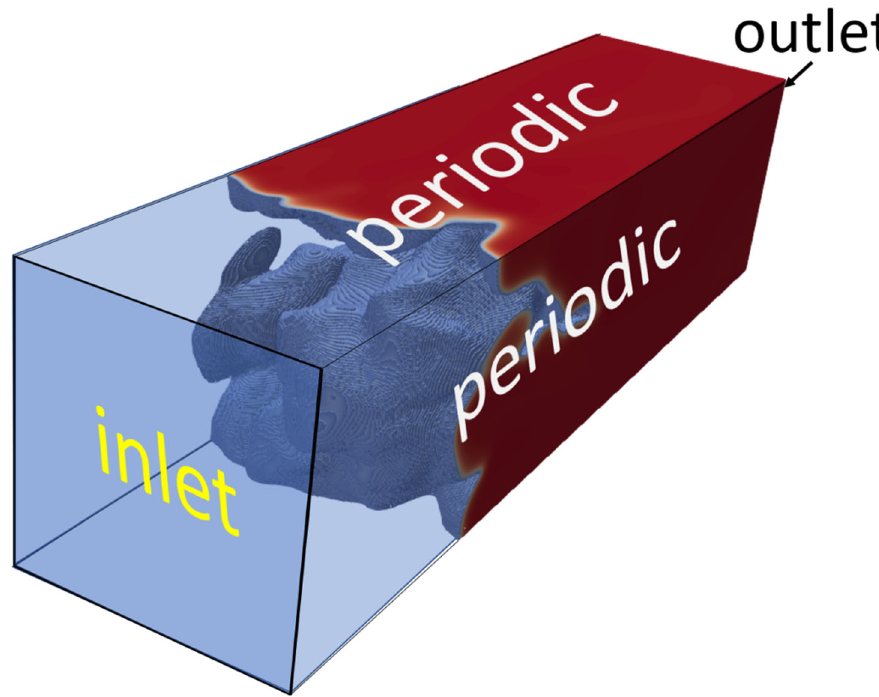
Figure 3. Central perspective of a general DNS of a turbulent flame brush.